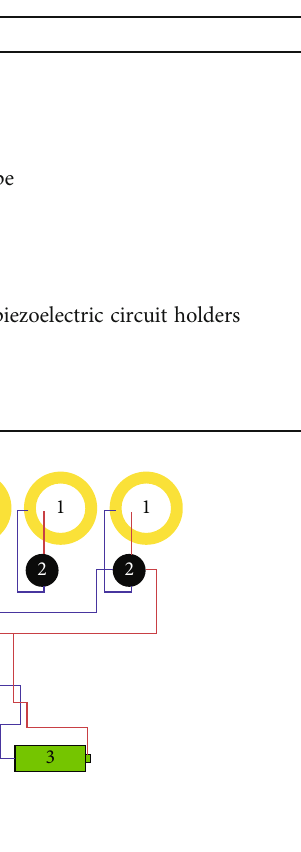
Table 1: Cov-TOTAL model component size.